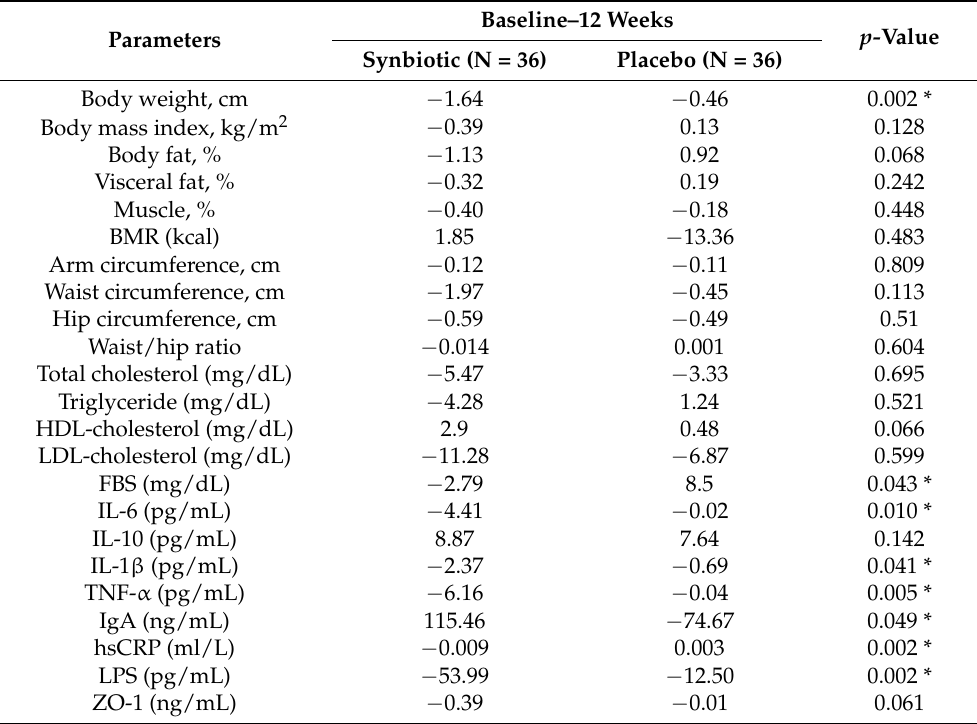
Table 4. Comparison of the changes in studied parameters between groups. Changes represent the difference between baseline and at the end of the study.